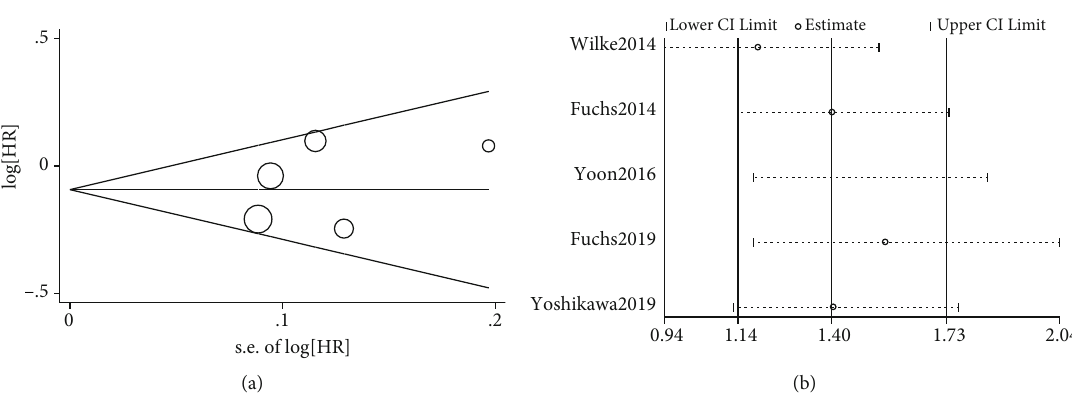
Figure 5: (a) Begg ’ s funnel plot of publication bias. (b) Sensitivity analysis of the pooled objective response rate